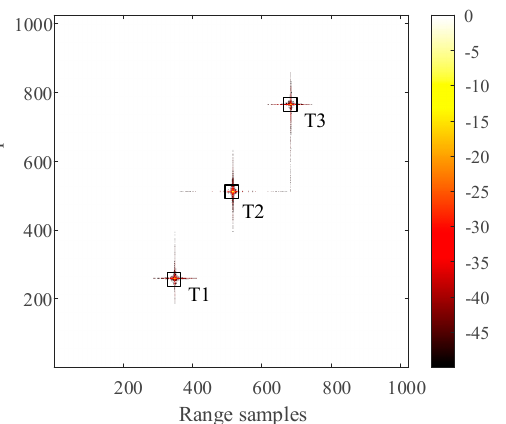
Figure 14. The Imaging result of three-point targets with the algorithm proposed in this paper (dB).